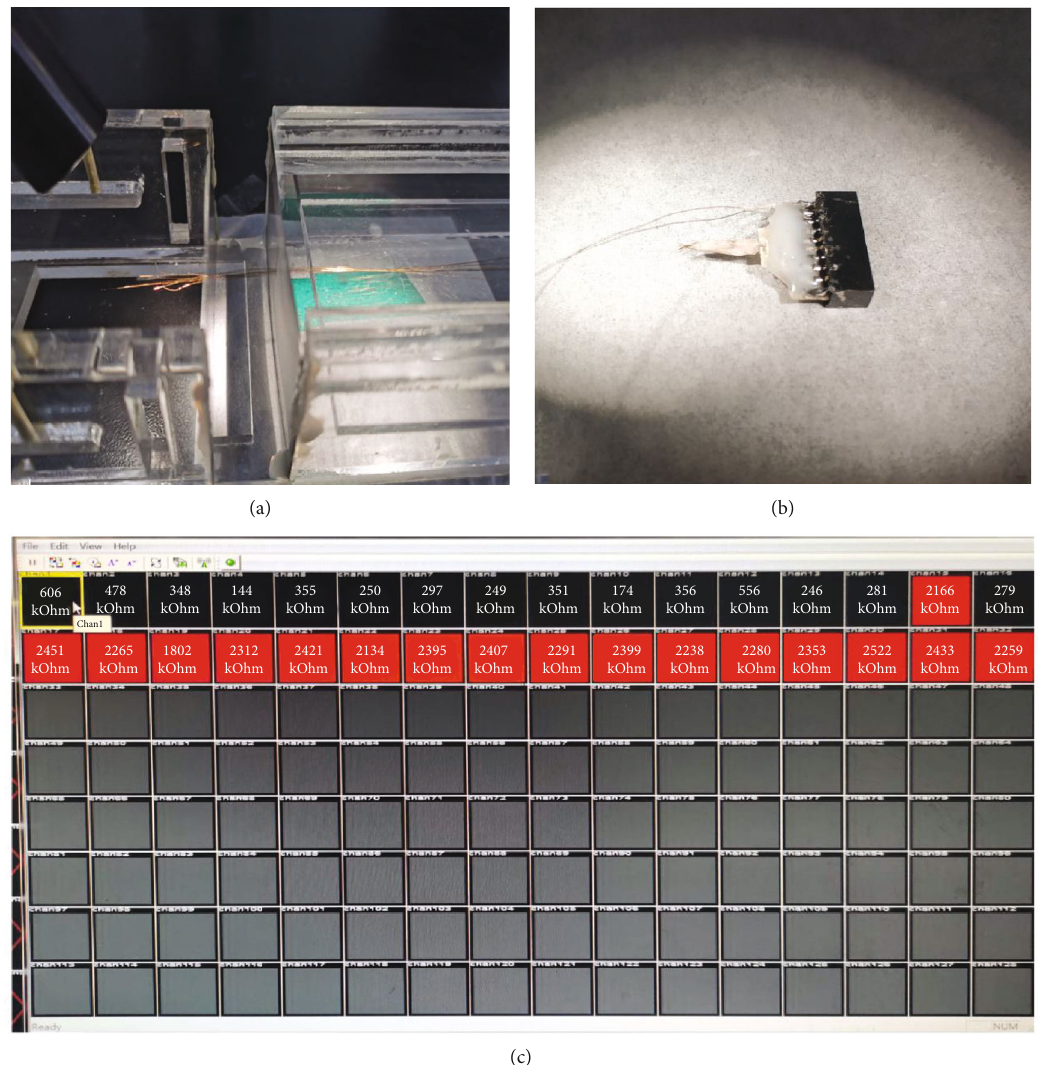
Figure 1: (a) Electrode mold. The electrode wire (12 – 30 μ m in diameter) needs to be manually passed through the mold to form a 4 ∗ 8 array, and the distance between the two electrode wires is 200 – 300 μ m. (b) A completed electrode. (c) Electrode impedance measurement; red represents a large